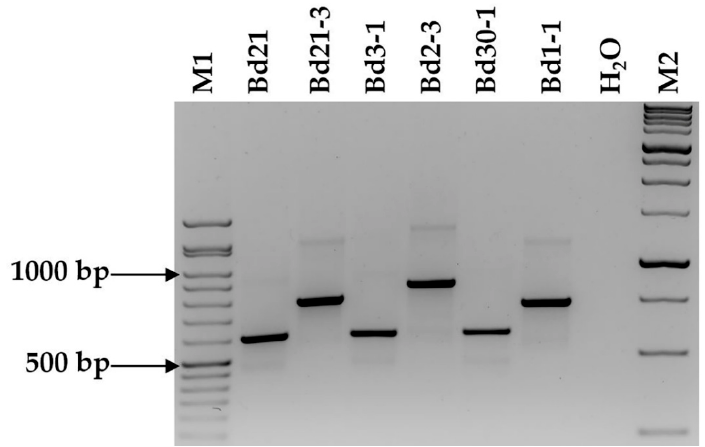
Figure 2. Multiallelism observed with the marker BdindelWSU_12 for six Brachypodium distachyon accessions. The amplicons were visualized on a 2% agarose gel stained with ethidium bromide. M1 represents the GoldBio ® 50 bp DNA ladder and M2 represents the GoldBio ® 1 kb PLUS ™ DNA ladder.